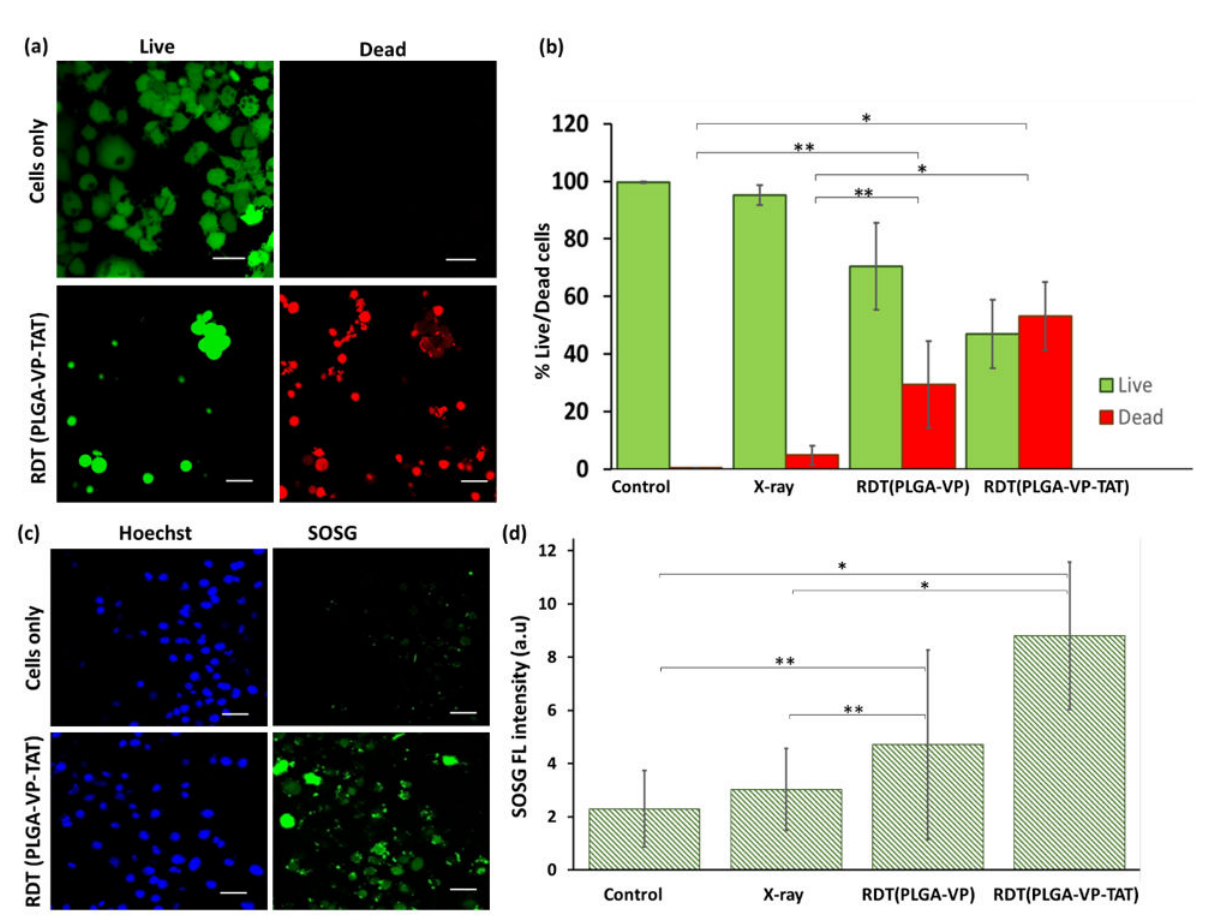
Figure 3. Cell viability and singlet oxygen generation following RDT. ( a ) representative confocal fluorescence image of live (green) and dead (red) cells following RDT with PLGA–VP–TAT NP and 4 Gy, compared to no-treatment controls, ( b ) corresponding cell viability, ( c ) representative confocal fluorescence image of SOSG fluorescence (green) and nuclear staining (blue) following 4 Gy RDT with PLGA–VP–TAT NPs compared to untreated controls, ( d ) SOSG fluorescence in treated and control cells, * p < 0.05 and ** p < 0.5. Scale bar: 50 µ